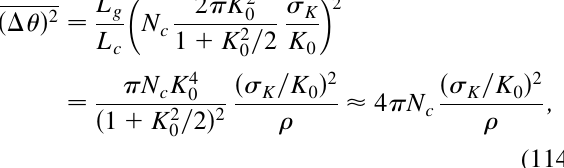
at FEL satura- 0 K . The rms K